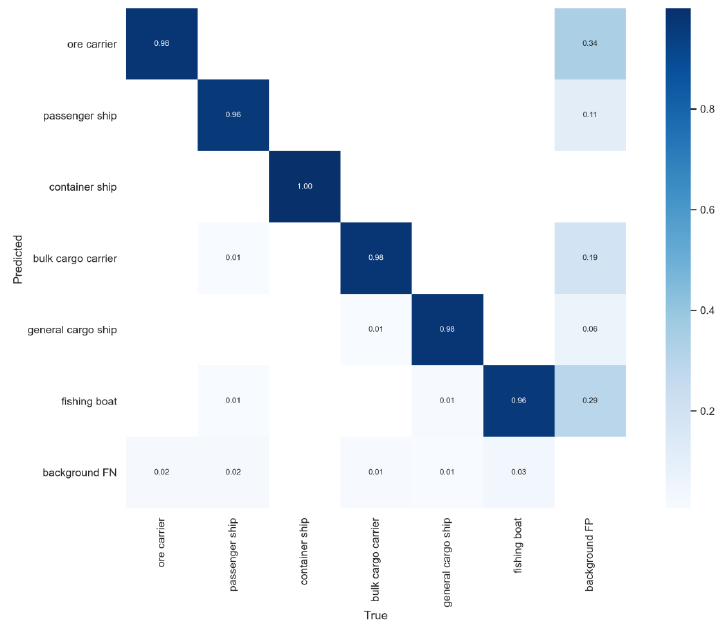
Figure 10. Confusion matrix of YOLOv5s.